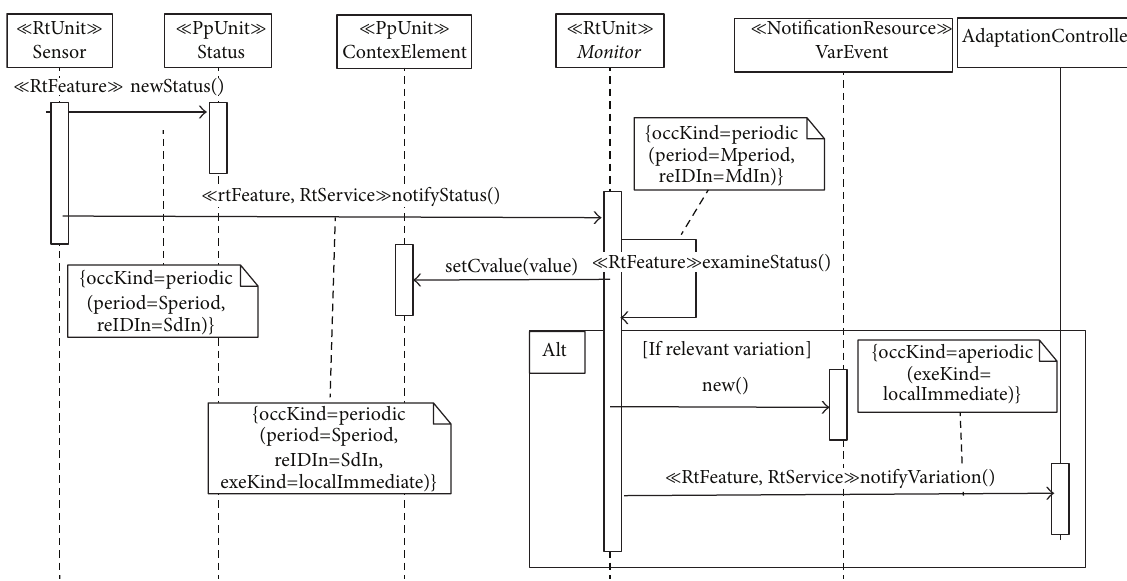
Figure 4: Behavioral view of the RTE Monitor pattern.